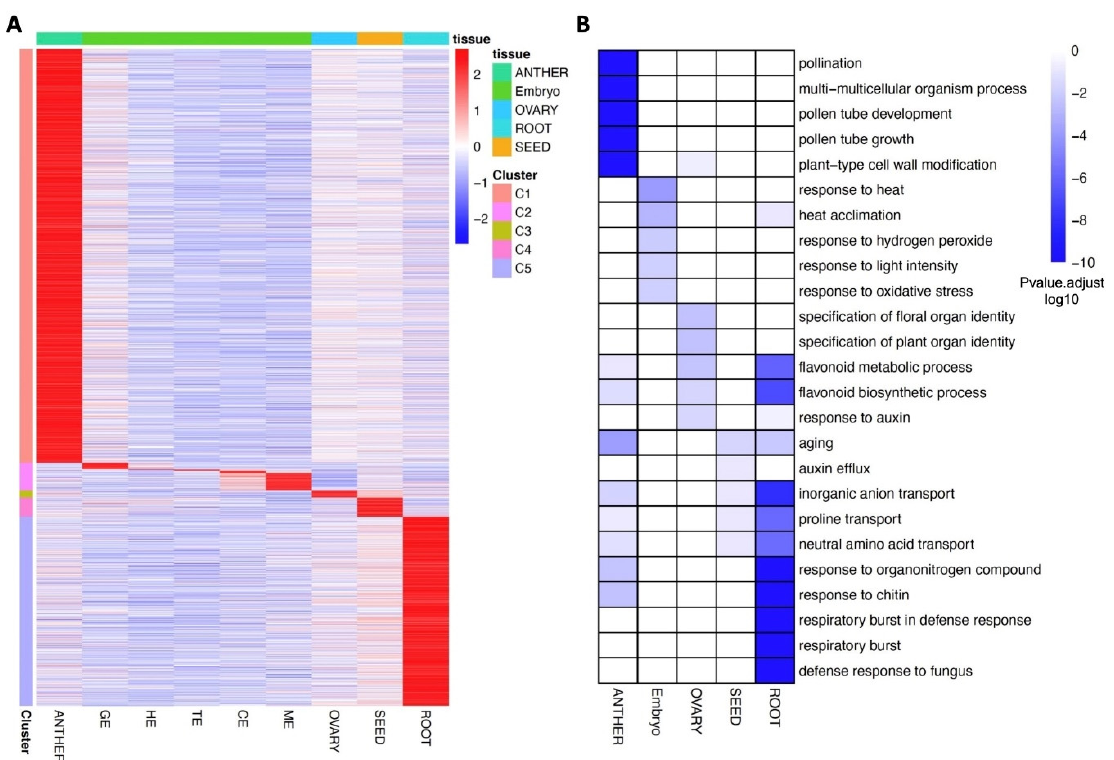
Figure 3. Dominant expressed genes in different tissues. ( A ) Heatmap of expression dynamics of gene members in five clusters (C1 to C5) representing tissue-specific expressed genes is shown. Genes in each cluster are associated with a color on the left of the heatmap. Different tissues and clusters are shown in different colors, as defined in the right inset. Z-score was applied for each row. For specificity, C1, anther; C2, embryo; C3, ovary; C4, seed; C5, root. ( B ) GO enrichment (biological process, BP) for each dominant gene cluster. A visual representation of GO enrichment for the genes in five tissue-specific clusters with enriched GO terms in the biological process category (on the y -axis) was plotted against each cluster ( x -axis). The GO terms with a significant ( p < 0.05) are shown and p -values are associated with colors shown in the right inset, from white (high) to blue